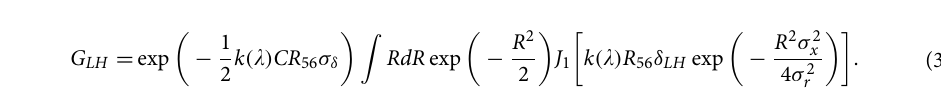
Figure 1. Microbunching gain for ( a ) Huang–Kim model and ( b ) Bosch–Kleman model. Blue lines correspond to MBI model without IBS, red lines to MBI with numerical IBS and magenta lines to MBI model with the newly introduced analytical expressions for